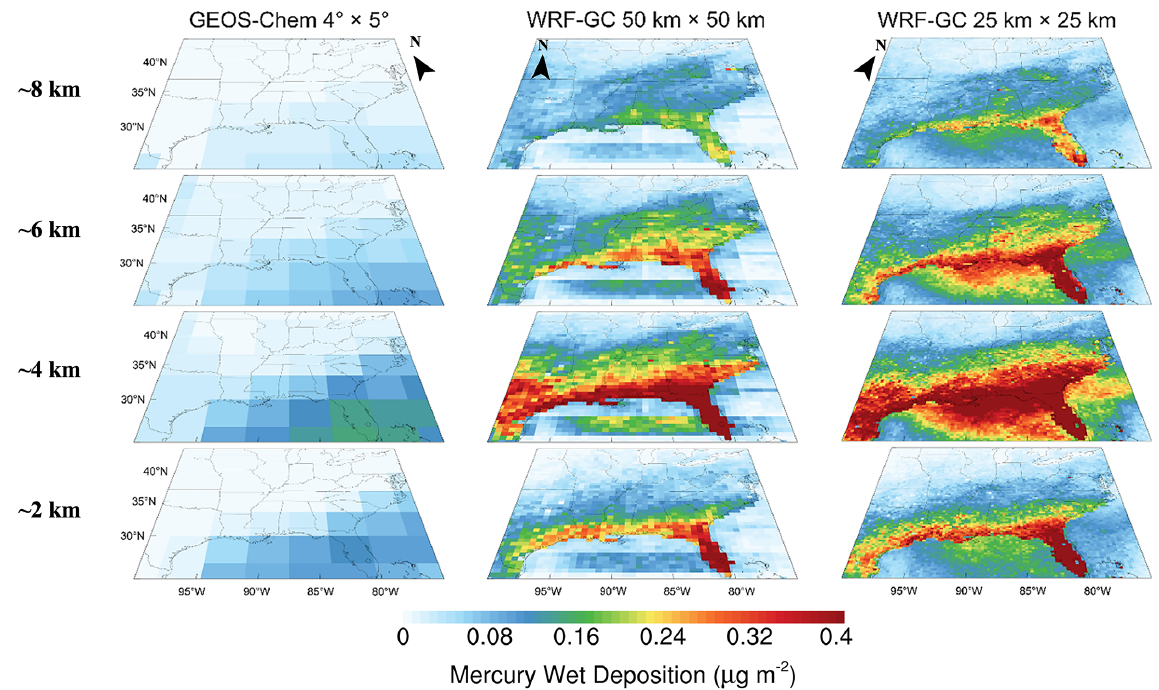
Figure 11. Comparison of CONV of GEOS-Chem and WRF-GC at different levels and resolutions. From top to bottom: Hg wet deposition at ∼ 2, ∼ 4, ∼ 6, and ∼ 8km, respectively. The first column is GEOS-Chem 4 ◦ × 5 ◦ simulation results. Other columns from left to right correspond to different WRF-GC resolutions: 50km × 50km and 25km ×